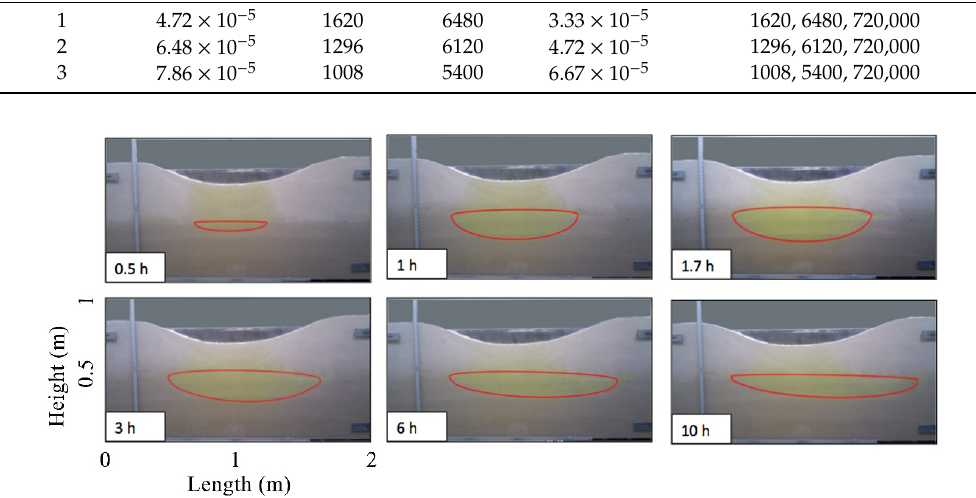
Figure 5. Physical model Simulation 2 shows IFL development and transient evolution. Table 3. The initial recharge rate ( R i ), time of recharge flux ( T q ), time of observed maximum thickness ( T max ), adjusted recharge ( R a ) rates, and stress period times for the numerical model simulations. Simulation